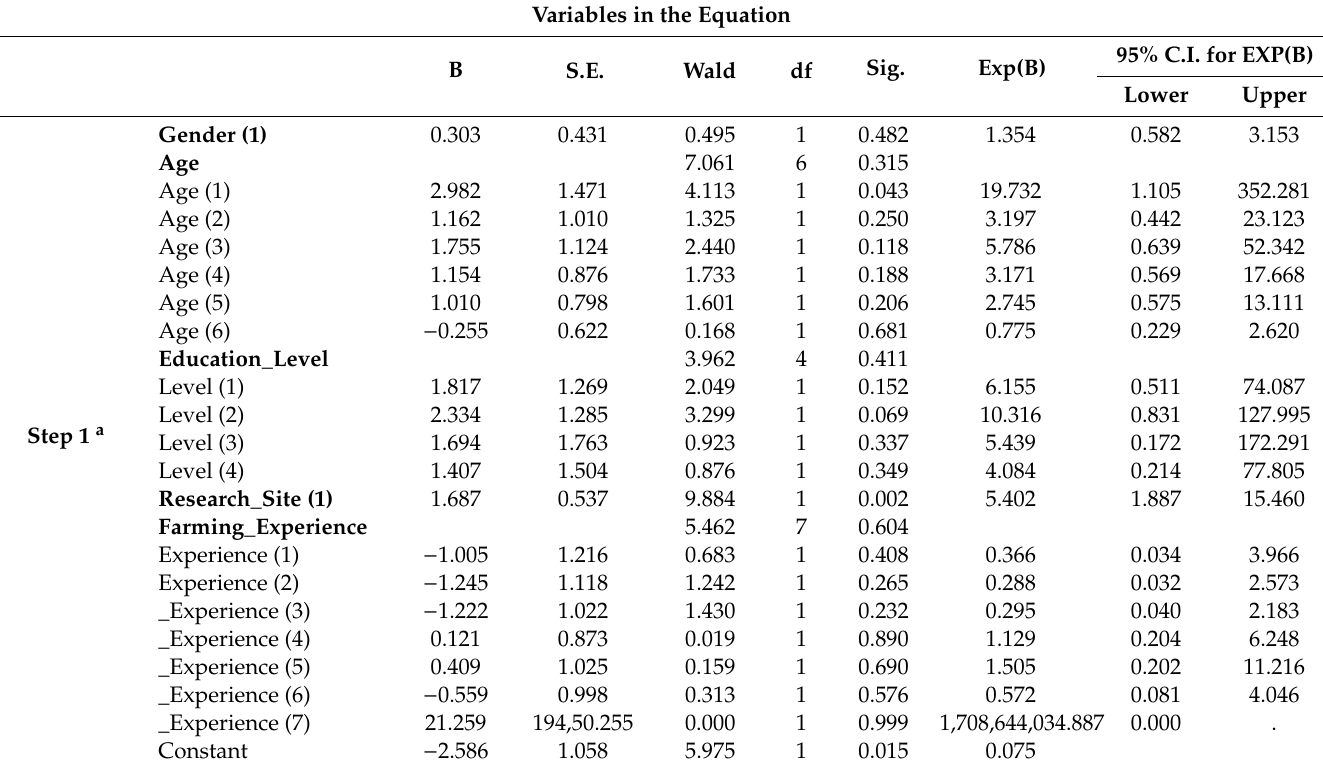
Table 2. Binary logistic analysis